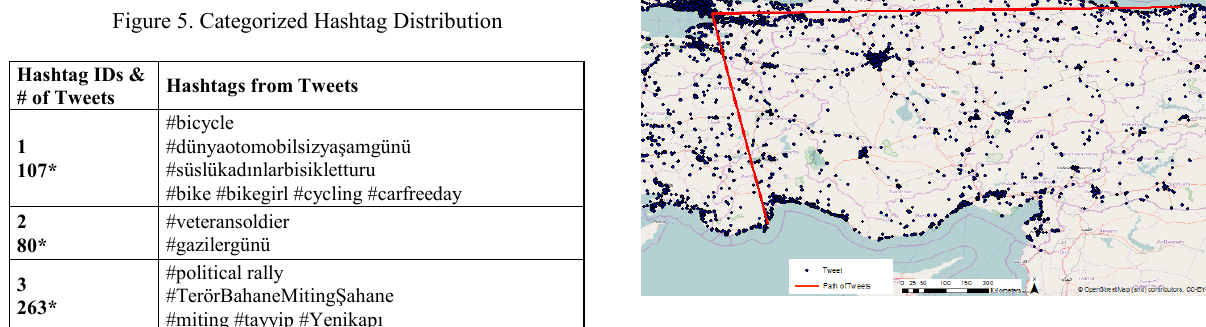
Figure 7. Routes within a short time interval as flight